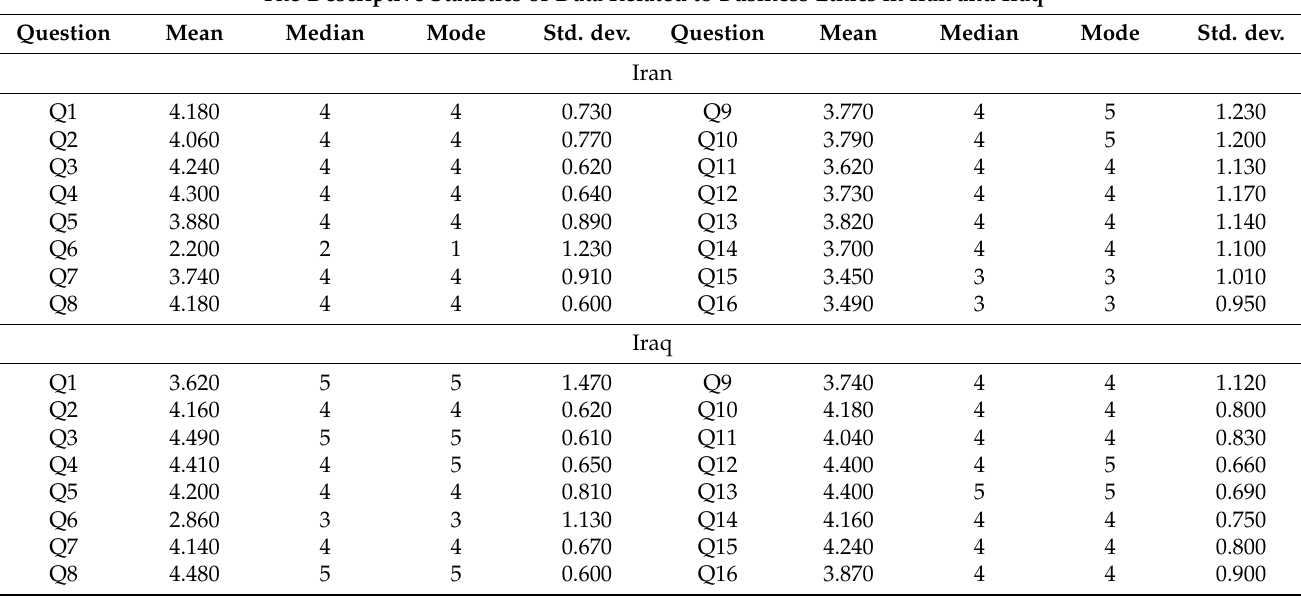
Table 3. The Descriptive statistics of data related to variables in Iran and